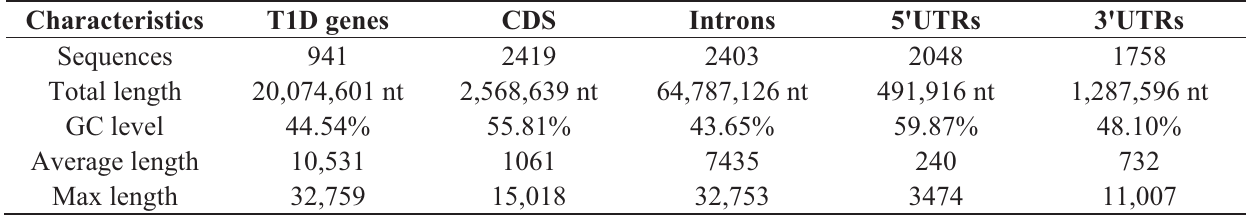
Table 1. Characteristics of T1D genes. The sequence-based characteristics of T1D genes, T1D coding sequences (CDS), T1D intronic sequences, and T1D UTRs are based on their length and GC content. The CDS, introns, and UTRs include all isoforms of the T1D genes.